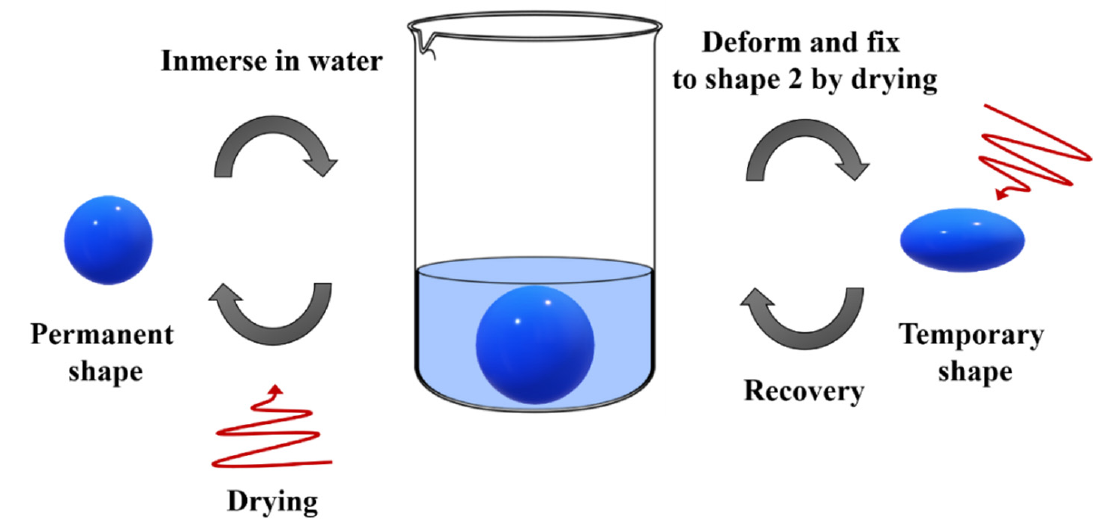
Figure 8. Mechanism of water-responsive shape recovery.